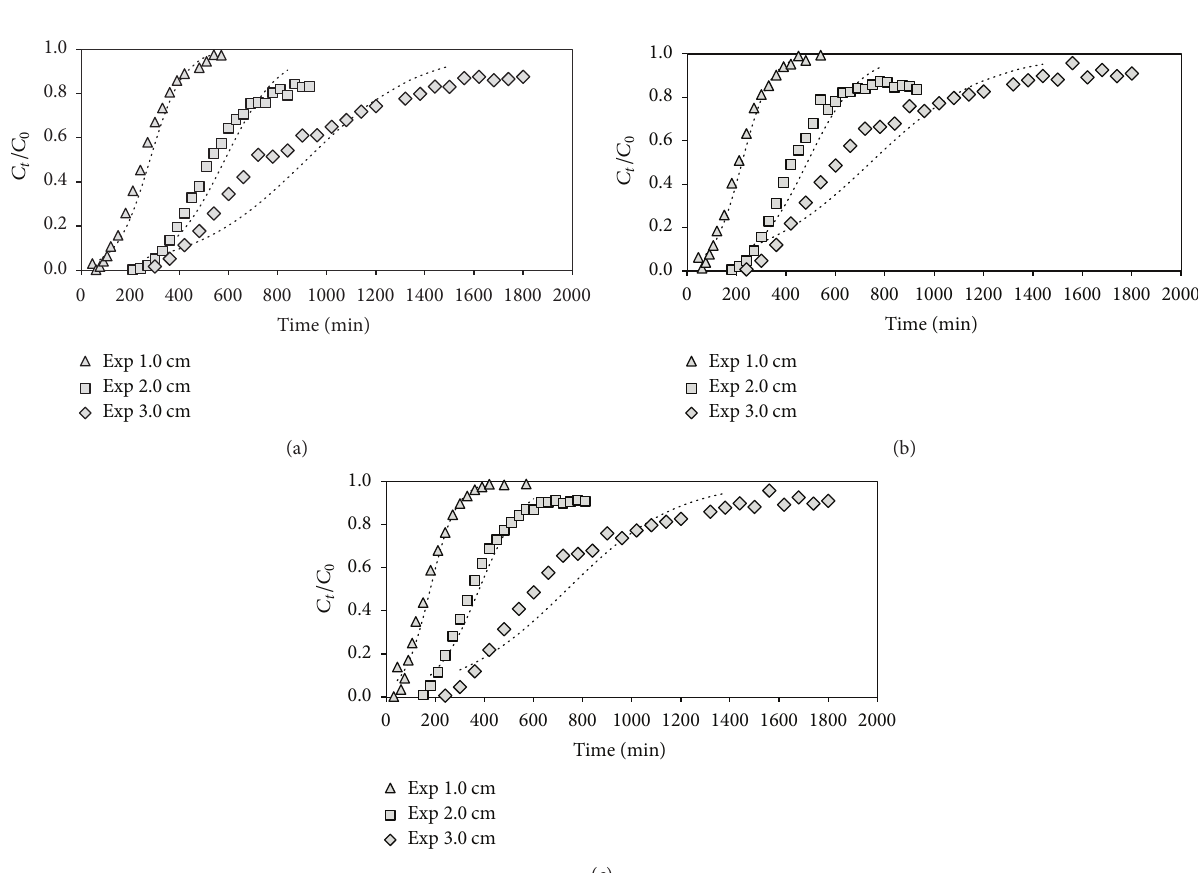
Figure 6: Experimental breakthrough curves at different bed heights of ternary metal solution of (a) Pb(II), (b) Cu(II), and (c) Ni(II) ( 𝐶 0 = 100mg/L; 𝑄 = 0.4 mL/min; model fit is shown as ⋅⋅⋅